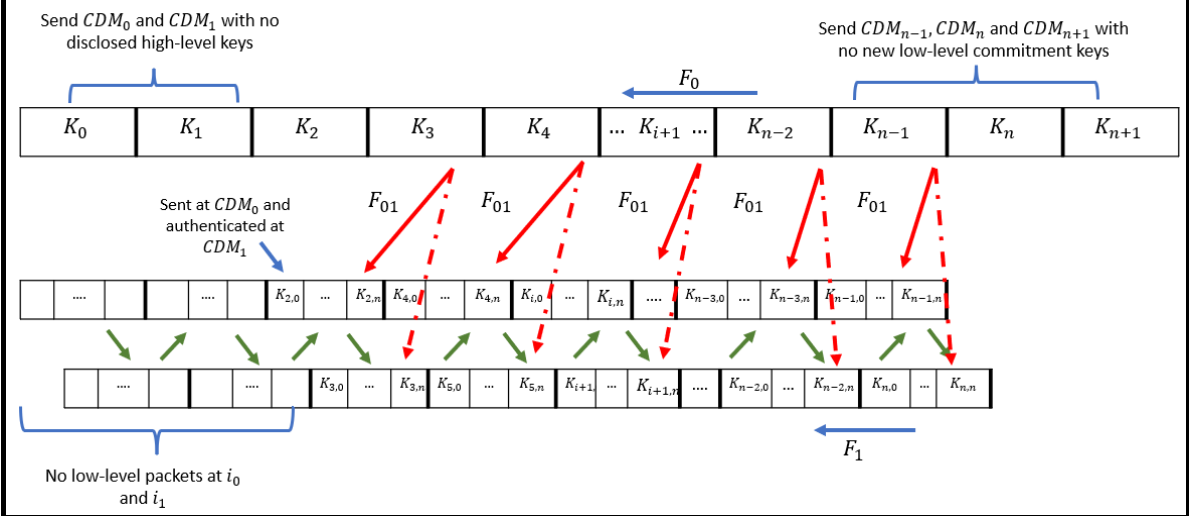
Figure 4. Final Structure of the Hybrid TLI-µTESLA Protocol including the exceptional packets in the high-level and the low-level keychains.